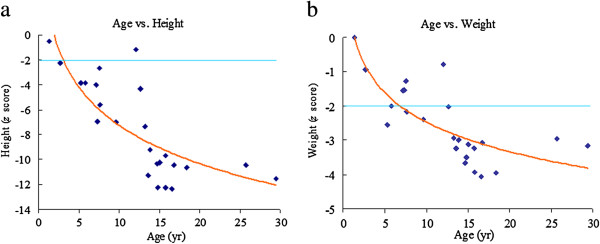
Age against standard deviation scores (z scores) for height (a) and weight (b) of 24 patients with MPS IVA. The values of the 2 parameters both decreased with age (p < 0.05). Horizontal lines represent the lower limits of normal.